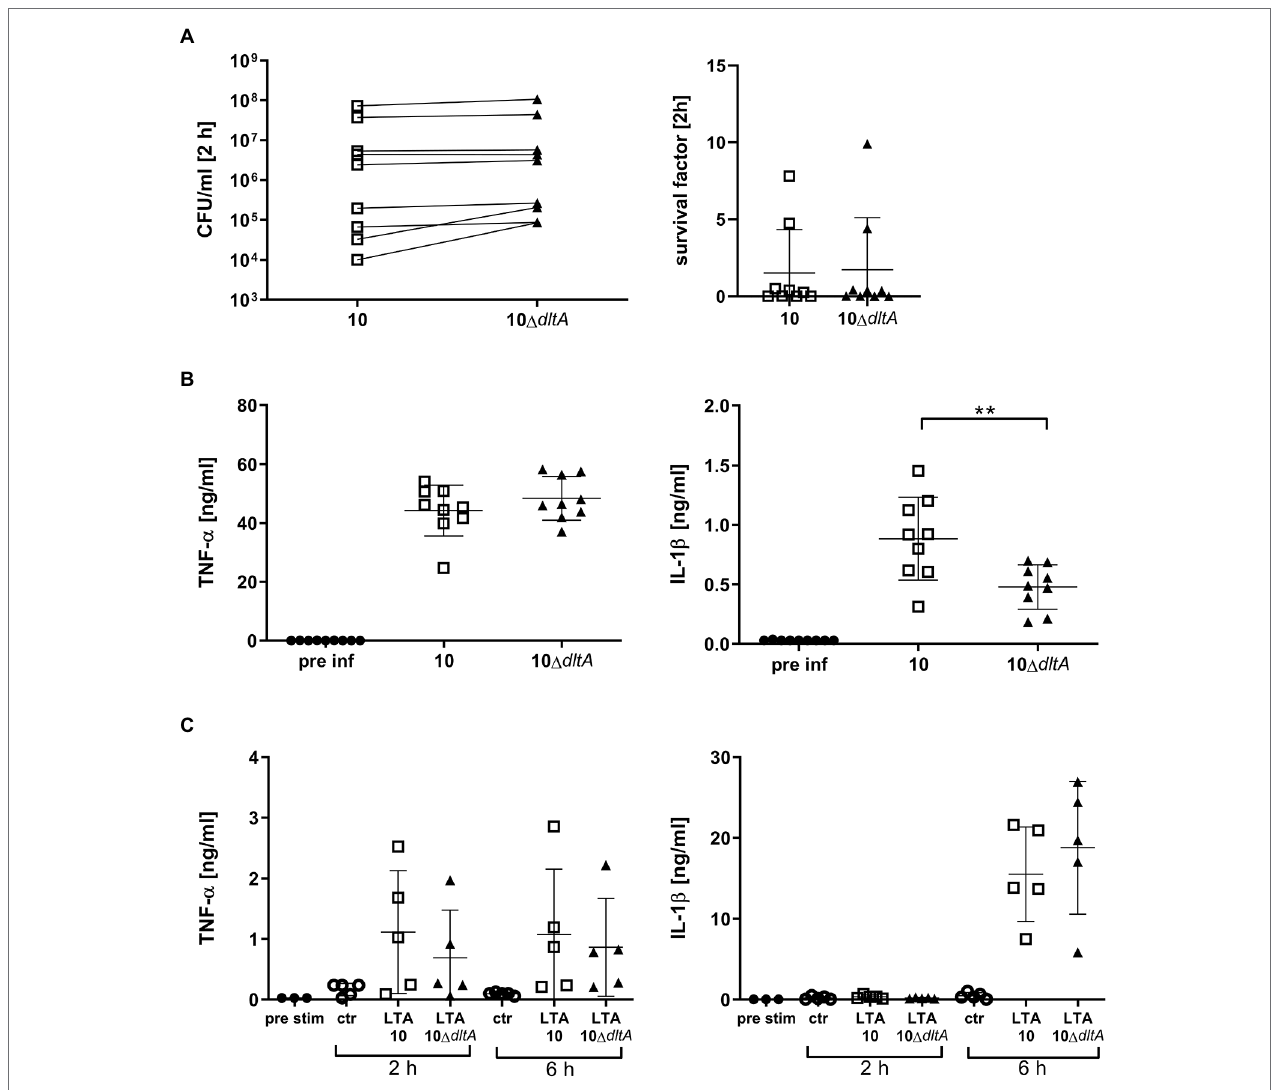
FIGURE 6 | Streptococcus suis strain 10 wt induces comparable levels of TNF- α , but higher levels of IL-1 β in porcine blood than the mutant 10 Δ dltA , while purified LTAs of wt and 10 Δ dltA do not show differences in IL-1 β induction upon addition to porcine blood. Whole porcine blood was infected with S. suis strain 10 and 10 Δ dltA at an inital CFU of 1 × 10 7 /ml. After 2 h infection, CFUs and survival factor (A) as well as TNF- α and IL-1 β levels in plasma (B) were determined. For (C) , blood was treated with 30 μ g/ml purified LTA obtained from strain 10 or 10 Δ dltA as indicated, whereby citric acid was used as a solvent for LTA. The equivalent volume of citric acid was used in control samples (ctr). Plasma was obtained after incubation as well as prior to infection (pre-inf) or stimulation (pre-stim), respectively, to determine cytokine levels by ELISA. The limit of detection was 0.016 ng/ml for TNF- α and 0.032 ng/ml for IL-1 β and all pre-inf and pre-stim samples lay below that limit. Lines in the left graph in (A) connect results of each individual blood donor. Horizontal lines and error bars represent mean values and SDs, respectively. For statistical analysis, paired t -test (A,B) or Wilcoxon matched-pairs signed rank test (C) was performed comparing wt and mutant samples. Differences that are not indicated are not significant. ** p <